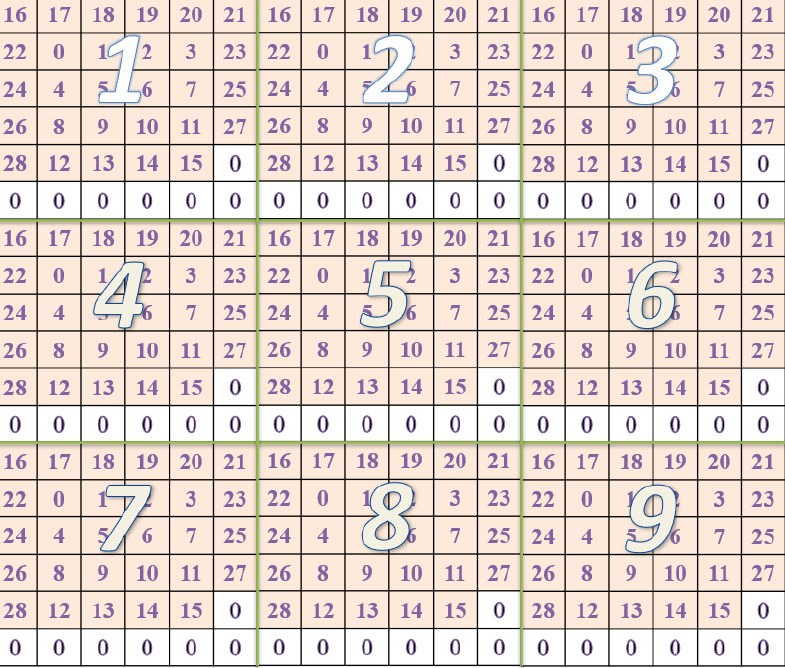
Figure 5. The data arrangement of 3 × 3 Mosaic pattern, with 29-bit ID.